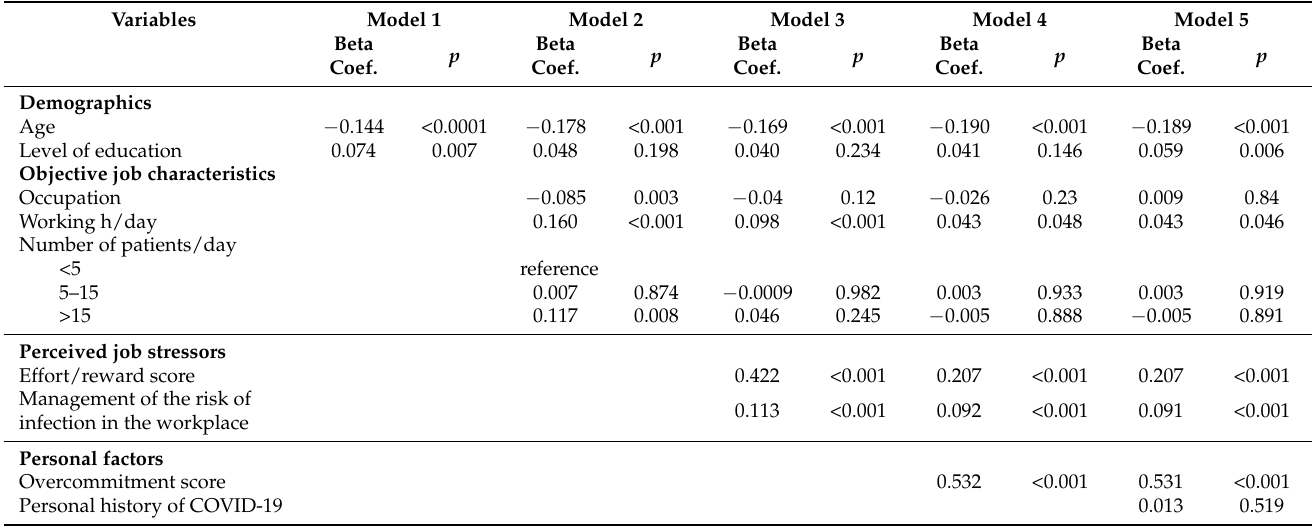
Table 3. Regression models of correlation between the risk factors and exhaustion score in